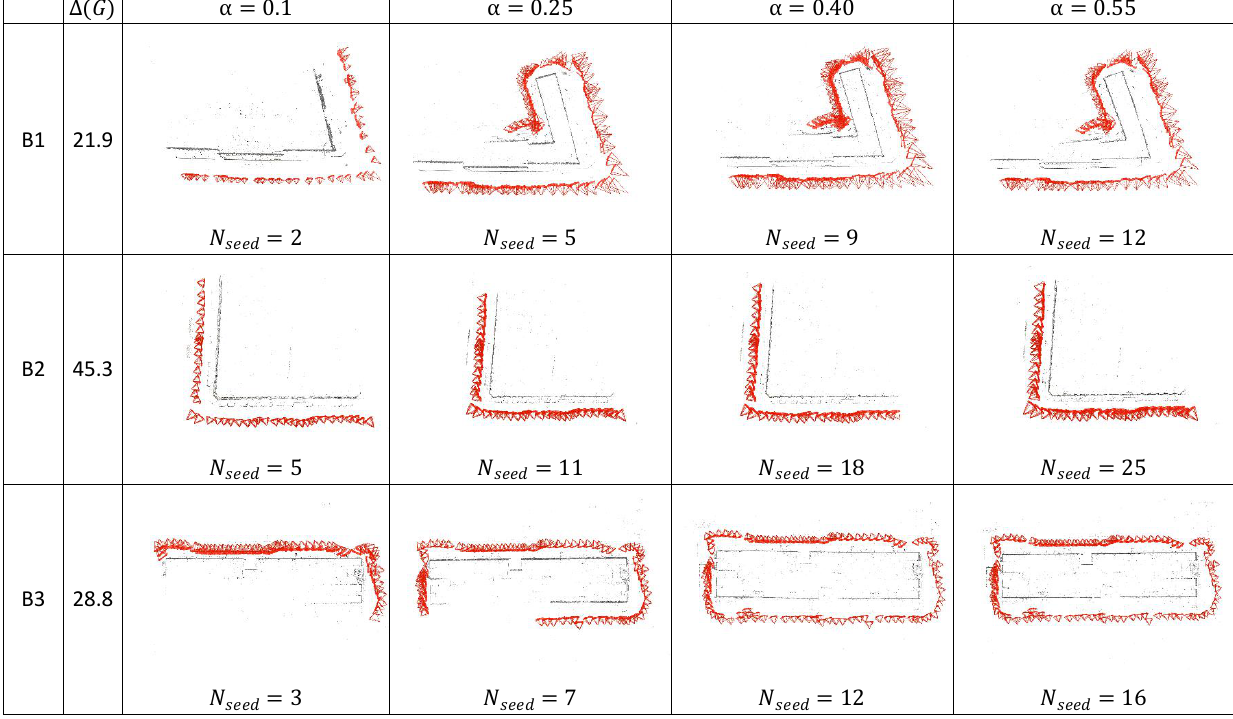
Figure 18. Seed reconstruction results for different values of α